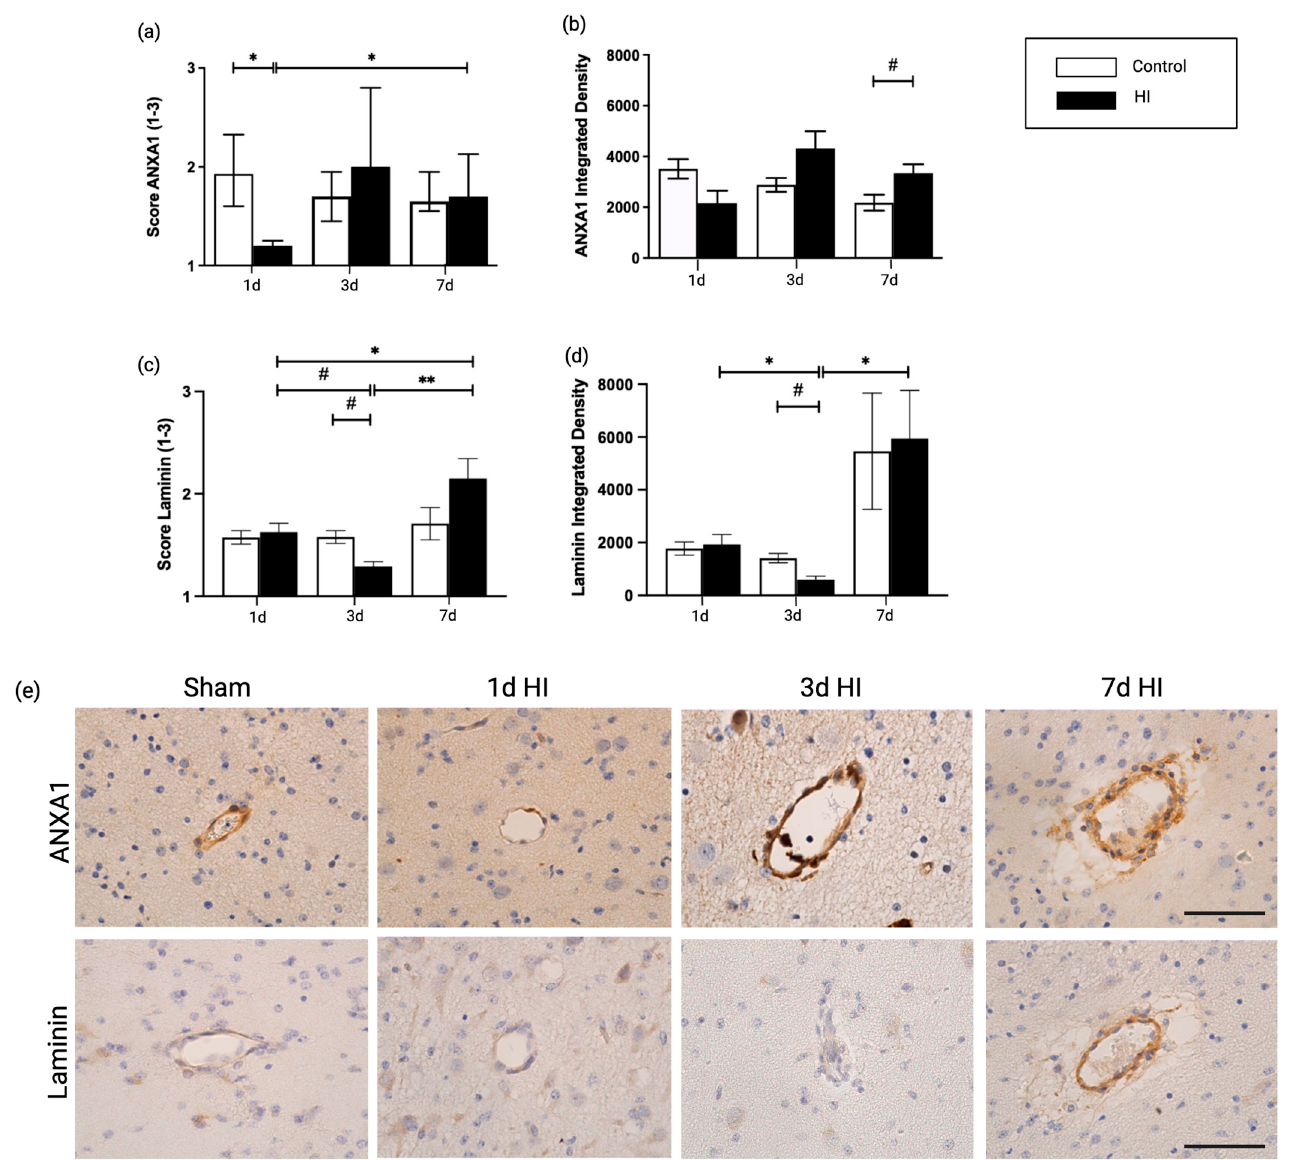
Figure 2. ANXA1 and laminin qualitative scoring ( a , c ), and integrated density measurements ( b , d ) on 1, 3 and 7 days after HI insult in the cerebral microvasculature; ( e ) representative images of consecutive sections of cerebral blood vessels stained with ANXA1 and laminin. An average of 40 fi elds of view per animal were analyzed. Graphs show the average integrated density per fi eld of view (mean grey value of stained area × percentage of stained area) for ANXA1 and laminin expression in coronal brain sections. Statistical analysis was performed with a Kruskal-Wallis test followed by Dunn’s post hoc test. Bars represent mean ± SEM. Scale bar 50 µm. 400× magni fi cation * p < 0.05, ** p < 0.01, # p = 0.06.